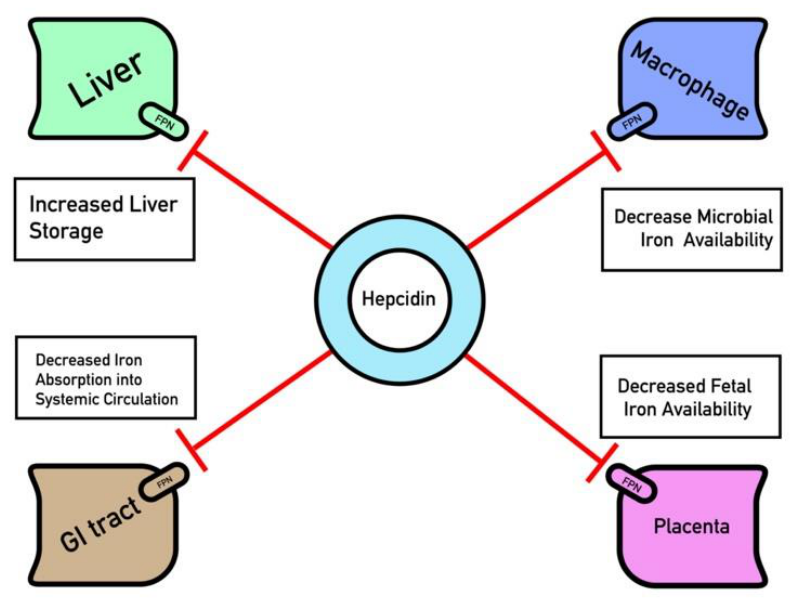
Figure 1. Ferroportin (FPN) regulation by Hepcidin. Key organ systems contain ferroportin channels that are degraded by hepcidin such as the GI epithelium, reticuloendothelial macrophages, hepatocytes and placenta. Hepcidin is up-regulated in response to hyperfermia and inflammation, which serves to sequester iron within these tissues and decrease iron availability.